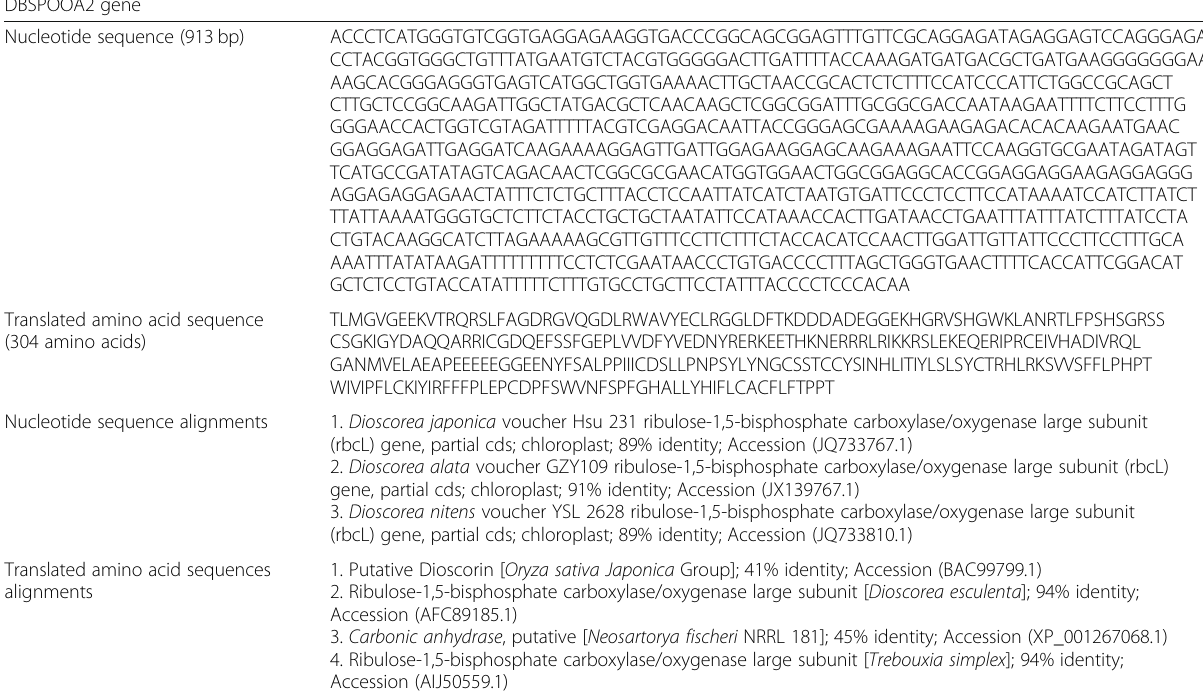
Table 3 Dioscorin gene DNA marker (DBSPOOA2-913) nucleotide sequence and deduced amino acid sequence alignments and homologous